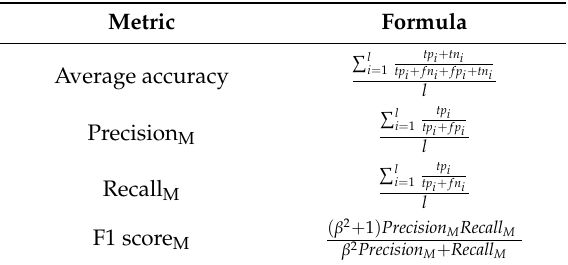
Table 5. Performance metrices for multi classification problem (dataset I).